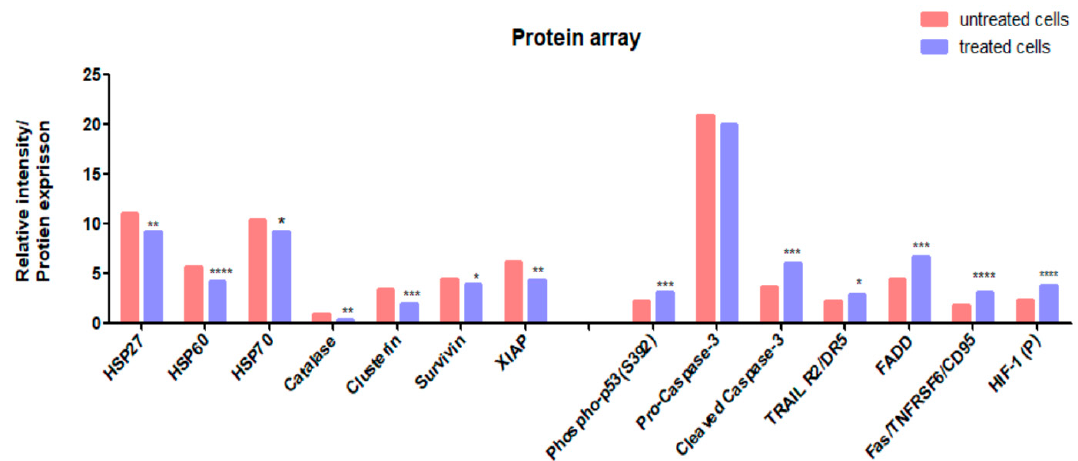
Figure 7. Relative expression of apoptosis-related proteins in the cell lysate of CADMN-treated HepG2 cells and untreated cells using proteome profiler array kit. Data were expressed as mean ± SD. * p < 0.05, ** p < 0.01, *** p < 0.001, **** p < 0.0001 indicate significant difference as compared to control